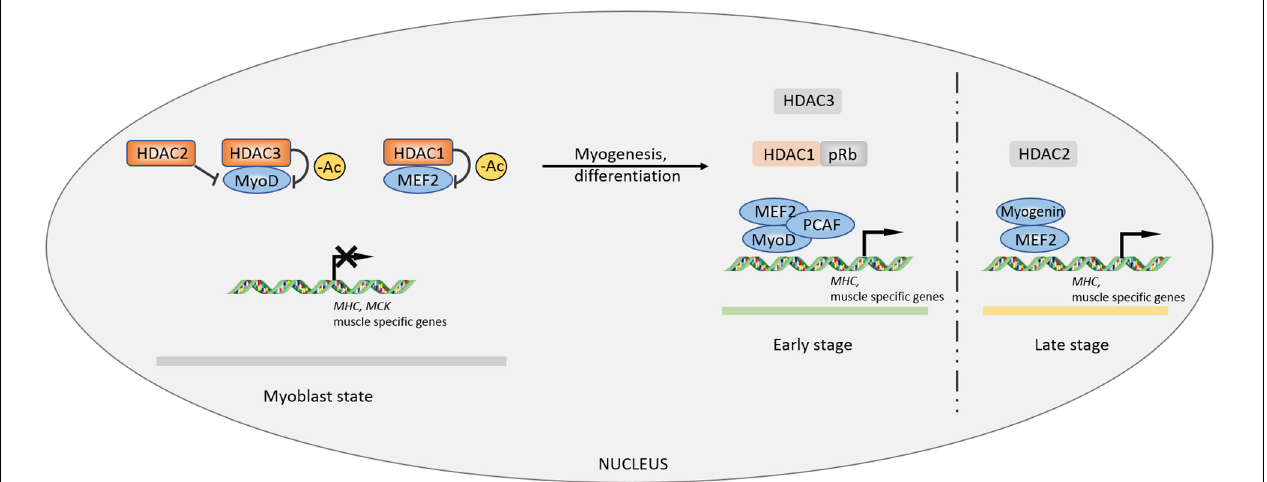
FIGURE 1 | Controls of myogenesis by Class I HDACs. The inhibitory effects of HDACs on myogenic factors MEF2 and MyoD maintain a primary myoblast state. During myocyte differentiation and myogenic process, the inhibition is lifted by other factors, facilitating MEF2-MyoD complex formation to promote myogenesis. –Ac,